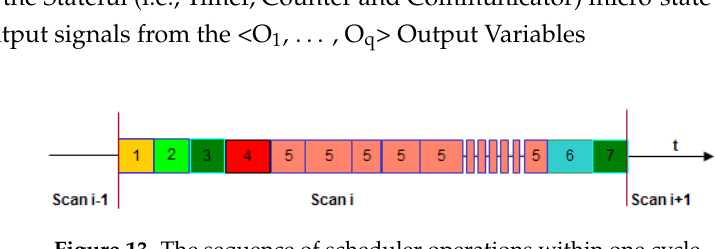
Figure 13. The sequence of scheduler operations within one cycle.